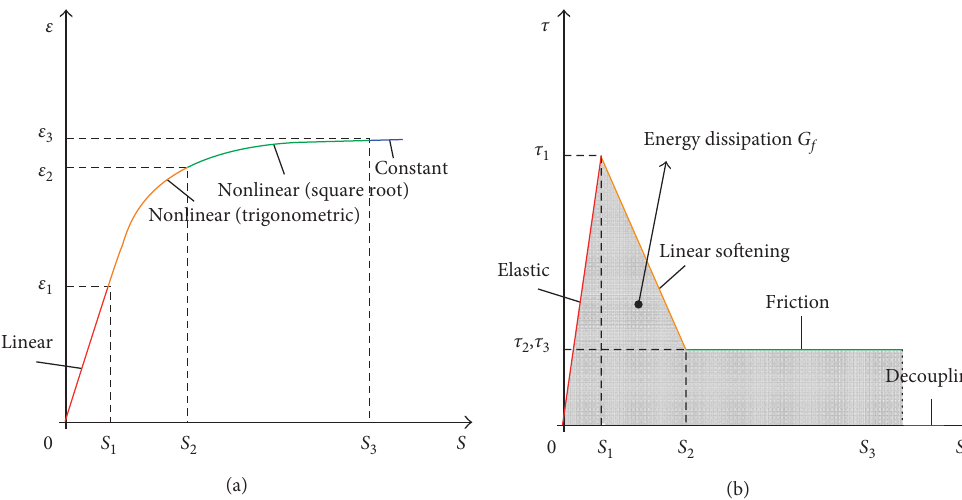
Figure 19: The corresponding relationship between the strain-slip curve and the interfacial bond-slip model. The strain-slip curve of the linear segment is corresponding to the interface bond-slip model of the elastic section. The nonlinear segment (trigonometric function) is corresponding to the linear softening section. The nonlinear segment (square root) is corresponding to the friction section, and the constant segment is corresponding to the fully decoupled section. (a) The strain-slip curve at loading end. (b) The interfacial bond-slip model. This figure is reproduced with permission from the American Society of Civil Engineers (all rights reserved) [35]. Table 9: The parameters of bamboo-modified slurry interface bond-slip model (mean). Interface Bamboo bolt-modified